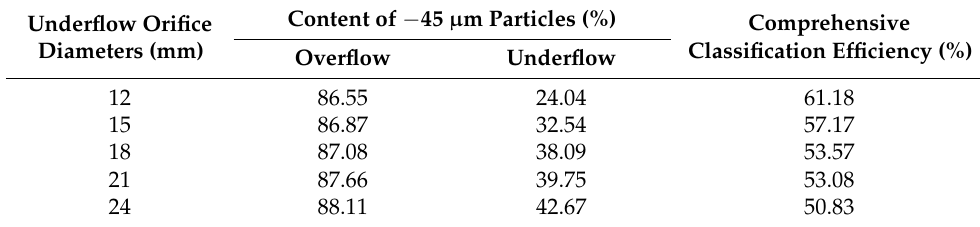
Table 8. Effect of the underflow orifice diameter on the classification performance of the hydrocyclone.